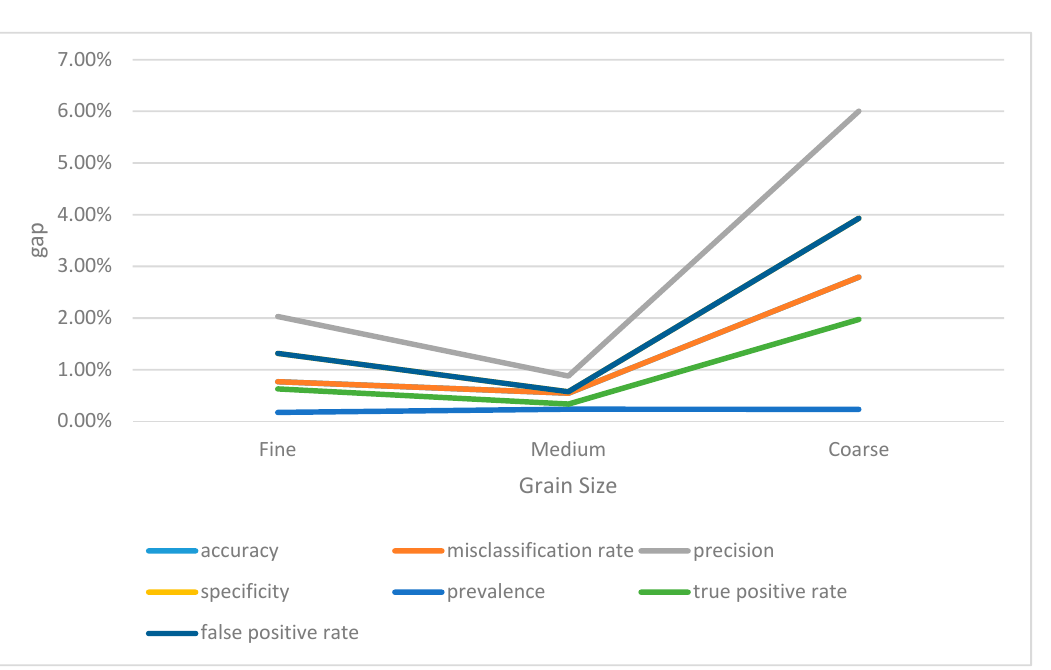
Figure 3. Confusion matrix indicator gap.